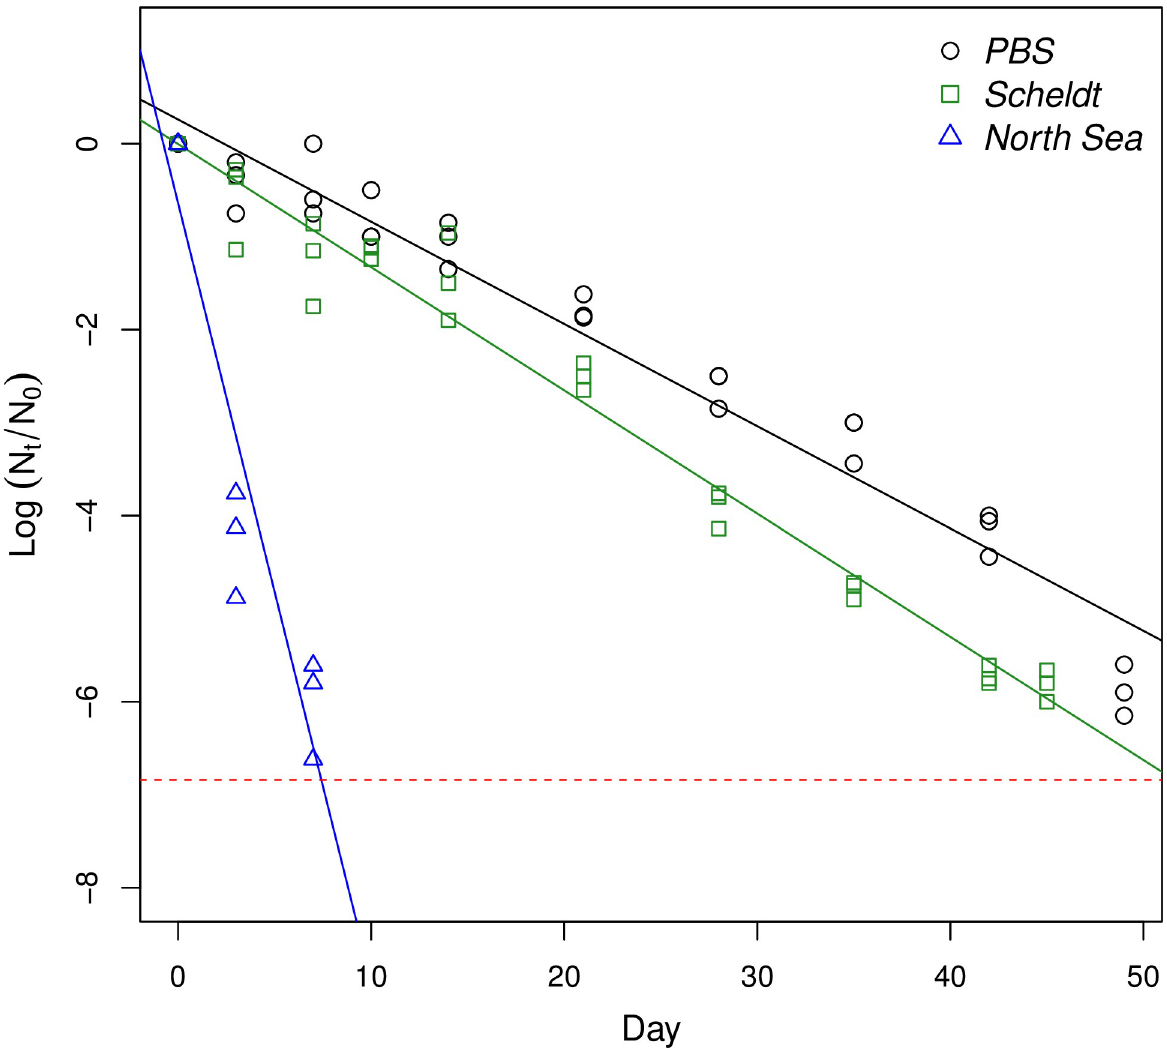
Fig 1. Long-term viral inactivation of PRCV, kept in the dark at 20˚C in PBS, river water (Scheldt) and natural seawater (North Sea). Values shown represent log 10 reductions in viral load at each time point. Dashed line represents the limit of detection of our test.